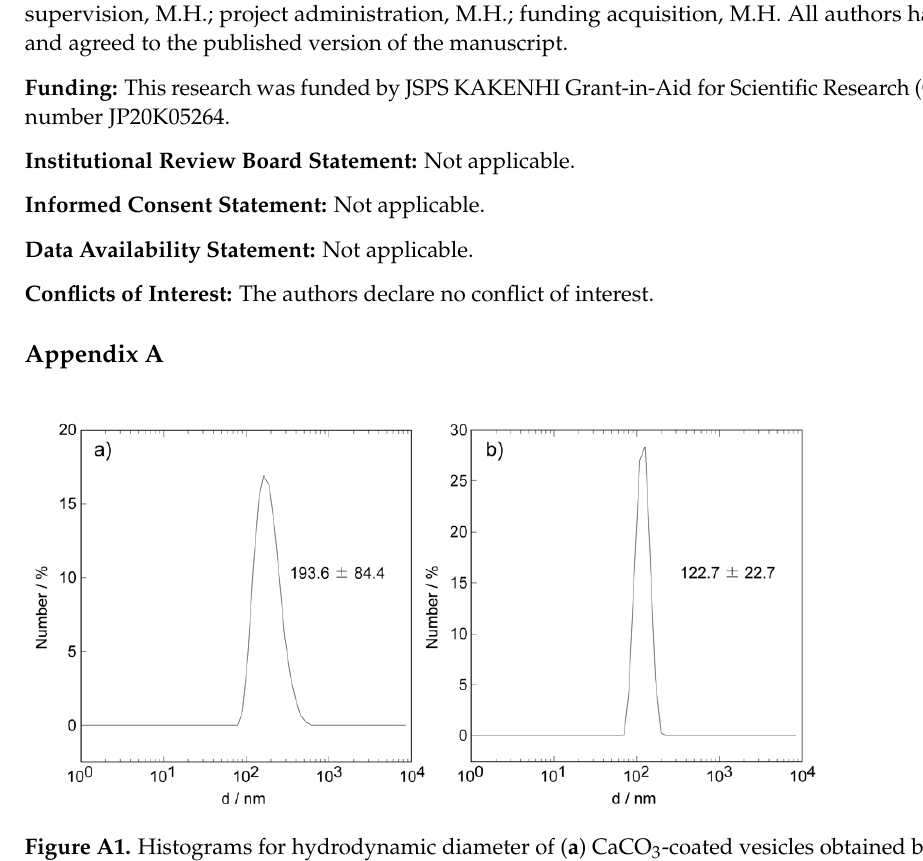
Figure A1. Histograms for hydrodynamic diameter of ( a ) CaCO 3 -coated vesicles obtained by 18-day mineralization, and ( b ) that of vesicles before mineralization.